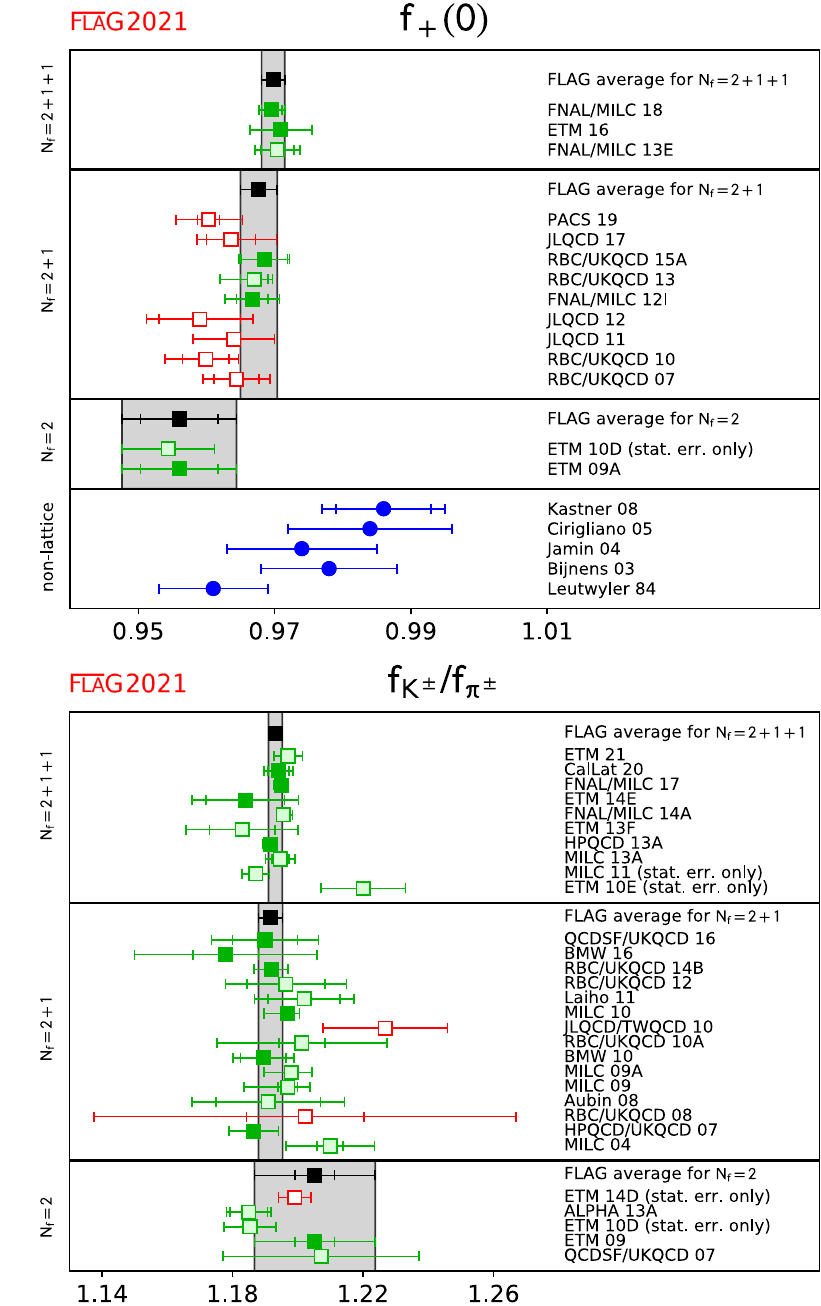
Fig. 8 Comparison of lattice results (squares) for f + ( 0 ) with various model estimates based on χ PT [283,285–288] (blue circles). The black squares and grey bands indicate our averages (76)–(78). The significance of the colours is explained in Sect. 2